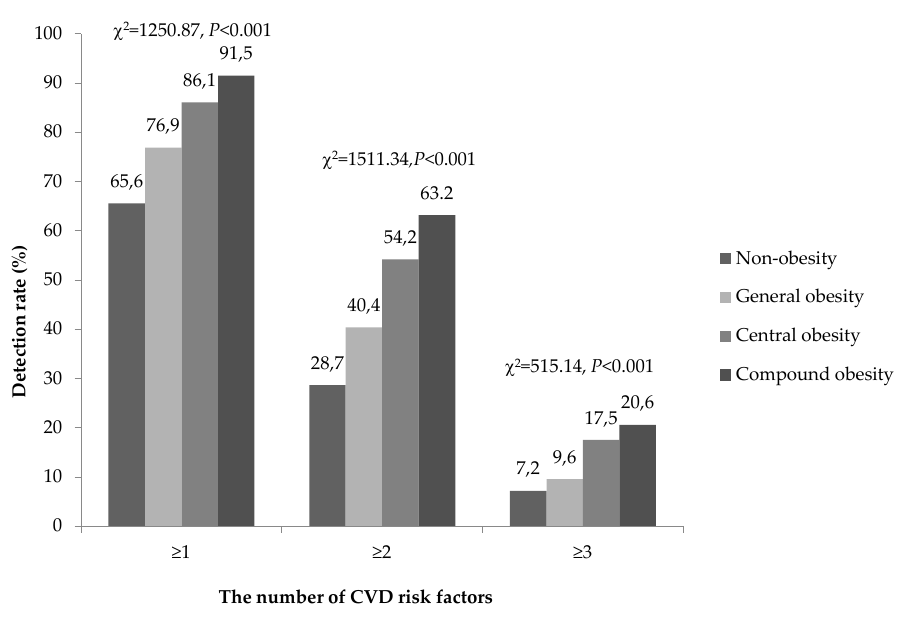
Figure 1. Detection rate of the number of clustered CVD risk factors in different types of obesity. Note: Linear-by-linear association.